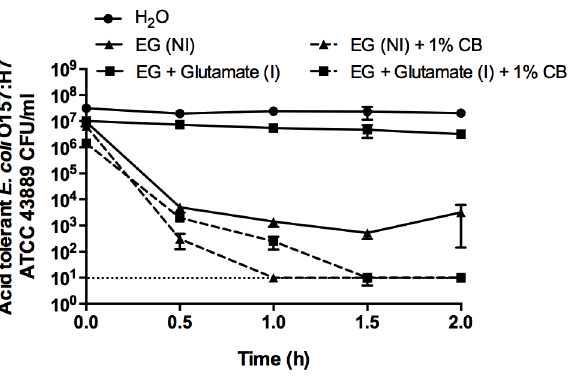
Fig. 2. Stationary-phase, inducible-acid-tolerant E. coli O157:H7 challenged in EG medium (pH 2.5) with (I, induced) or without (NI, non-induced) 2 mM glutamate. Experimental samples were exposed to a 1% CB suspension for 2 h. Data are presented as the mean ¡ SD for three independent experiments. The dotted line represents the limit of detection.